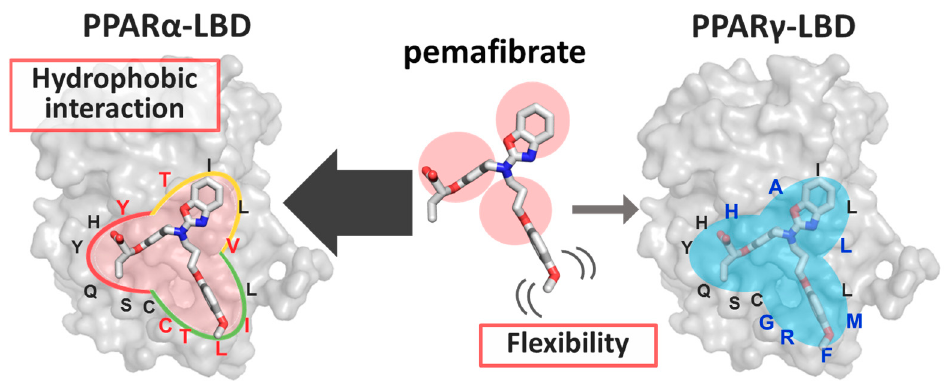
Figure 4. Schematic view of the molecular mechanism behind pemafibrate as a selective PPAR α modulator (SPPARM α ).